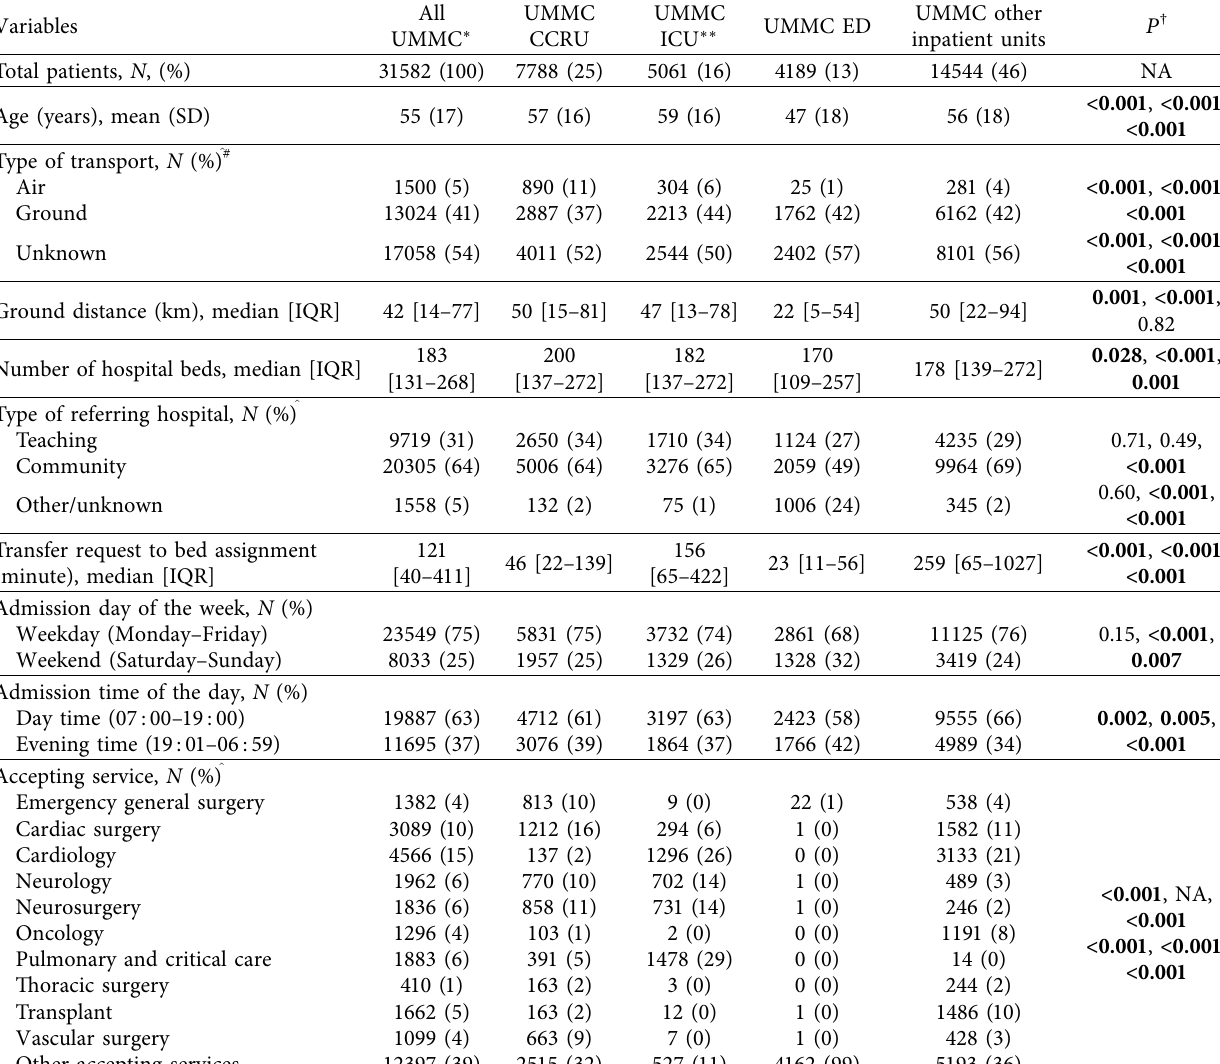
Table 1: Demographics and clinical features of patients from all UMMC units during the 5-year study period. Variables